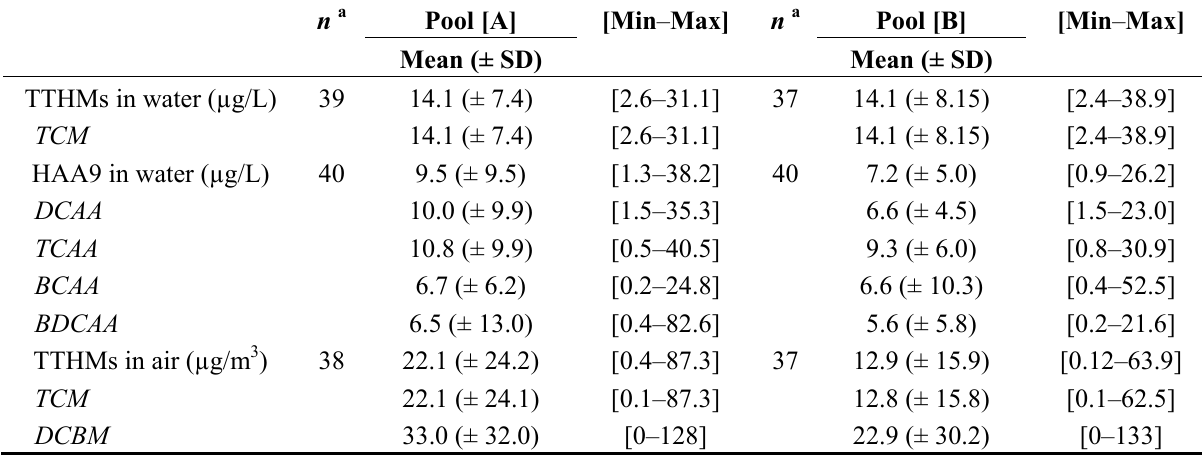
Table 4. Coefficients of variations (%) between the levels of DBPs measured at the various sampling places into the pool (for water contaminants) and around the pool (for air